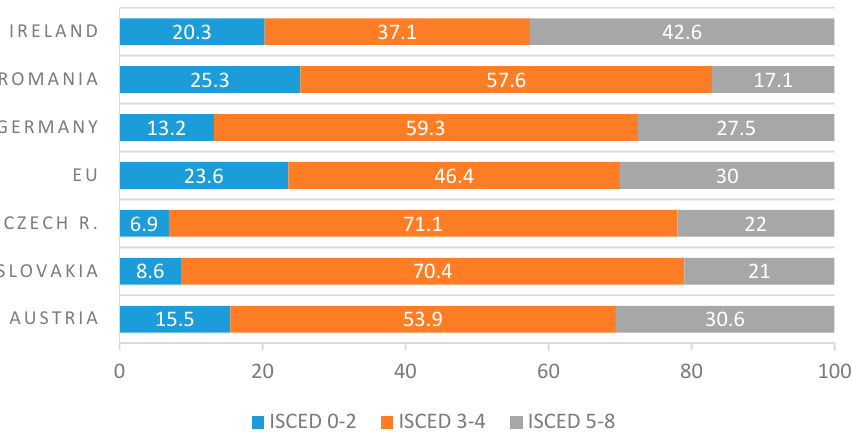
Figure 1. Share of educational attainment of population aged 25–64 in selected countries in 2015.